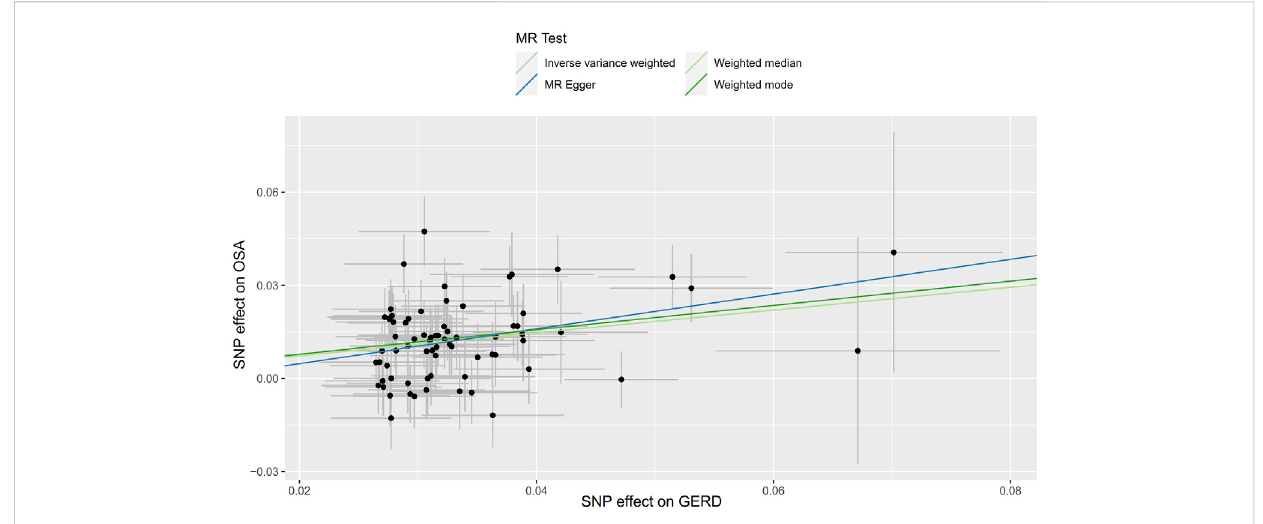
FIGURE 5 Scatter plot for the causal relationship of GERD on OSA. Abbreviation: MR, Mendelian randomization; SNP, single nucleotide polymorphism; GERD, gastroesophageal re fl ux disease; OSA, obstructive sleep apnea.